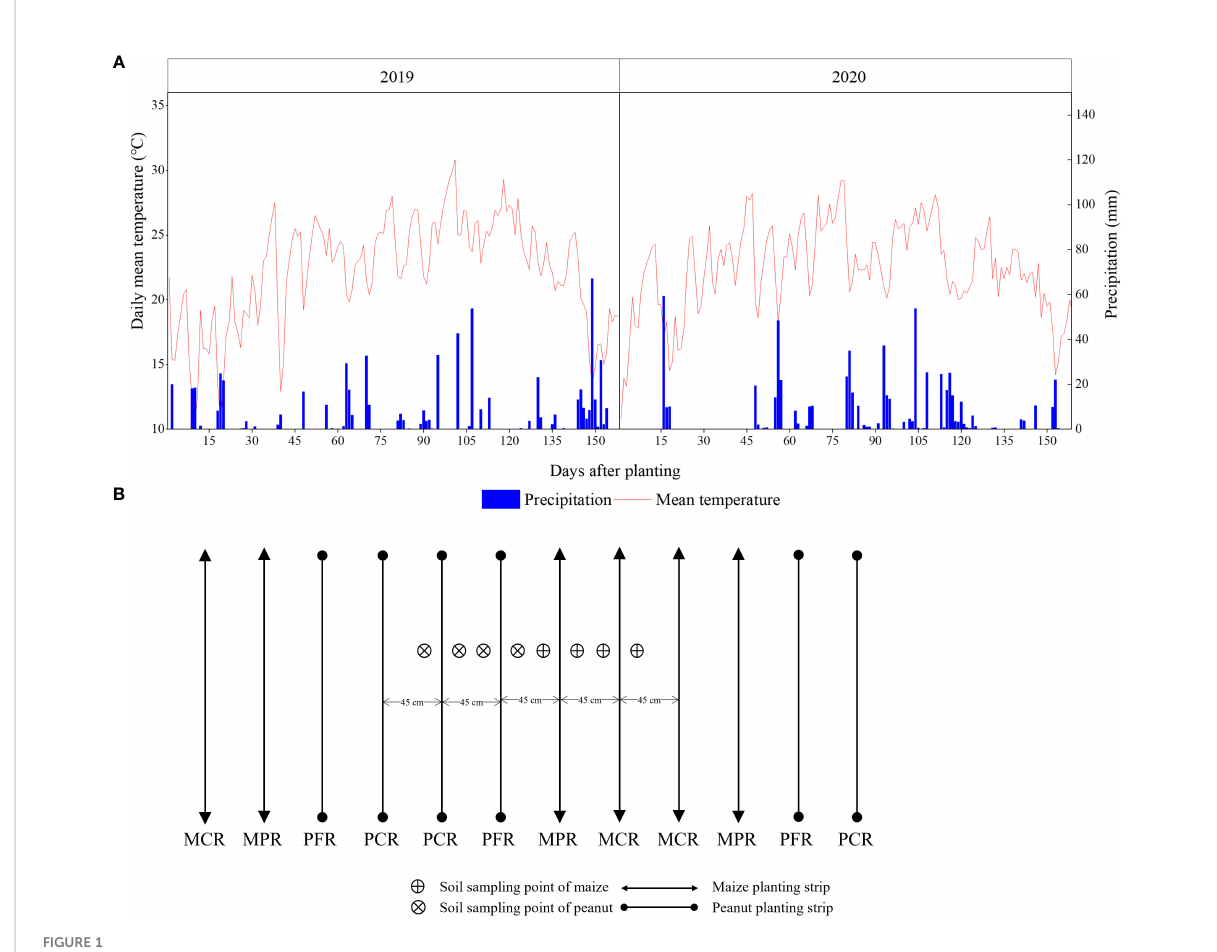
FIGURE 1 Daily climatic data (A) and sample location in intercropping (B)